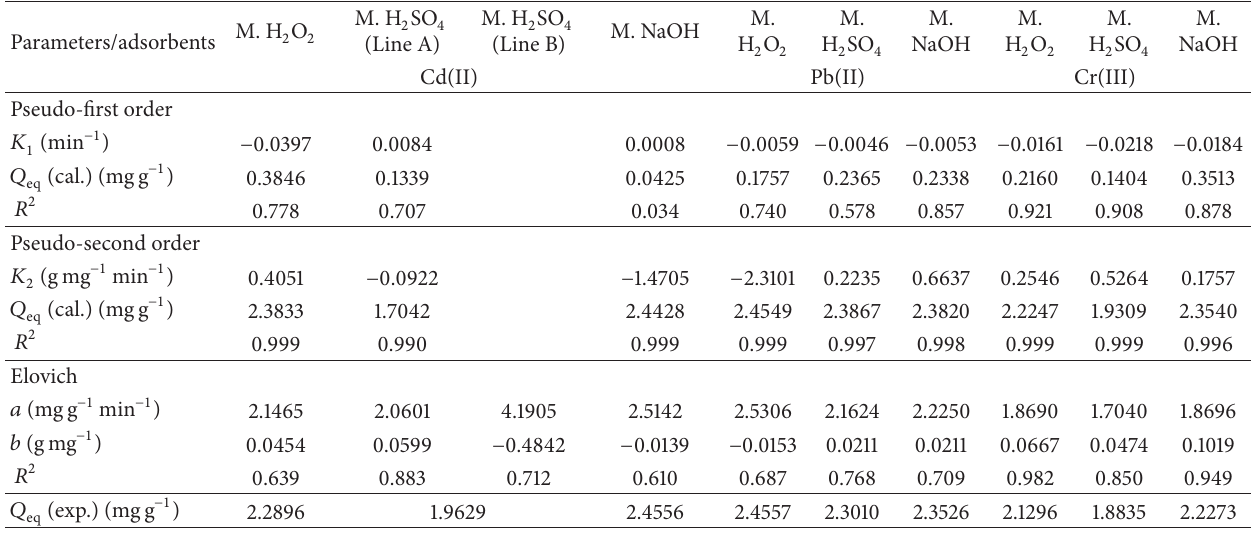
Table 6: Kinetic parameters referred to linear models of pseudo-first order, pseudo-second order, and Elovich obtained by adsorbents M. H 2 O 2 , M. H 2 SO 4 , and M. NaOH in the removal of Cd(II), Pb(II), and Cr(III) from water.